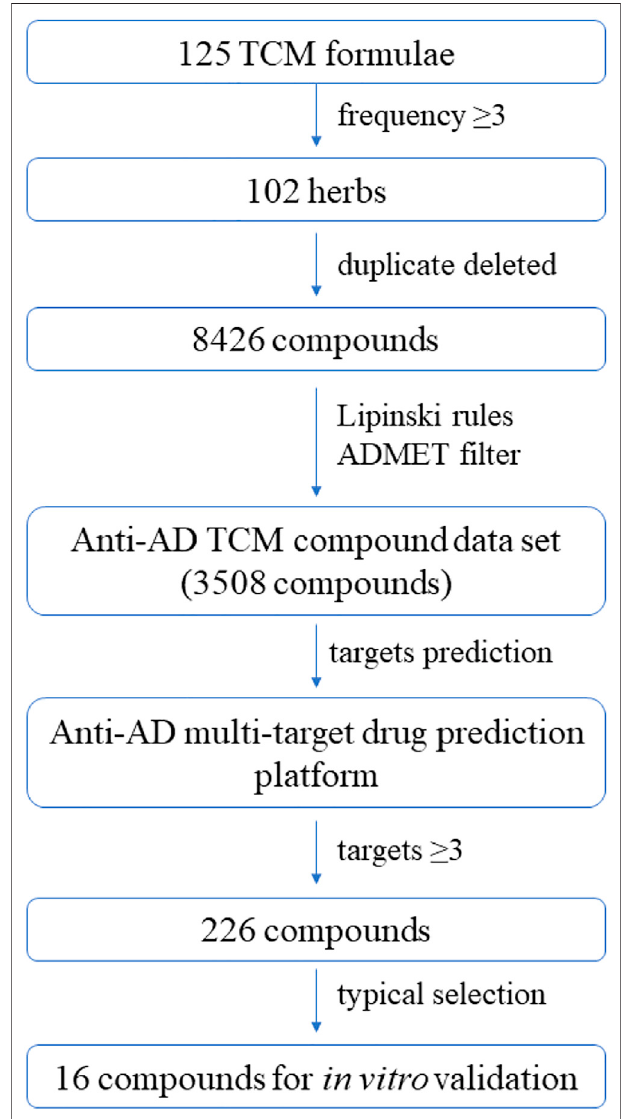
FIGURE 6 | Work fl ow of the integrated virtual screening and drug screening approaches for anti-AD multi-target compounds from TCM